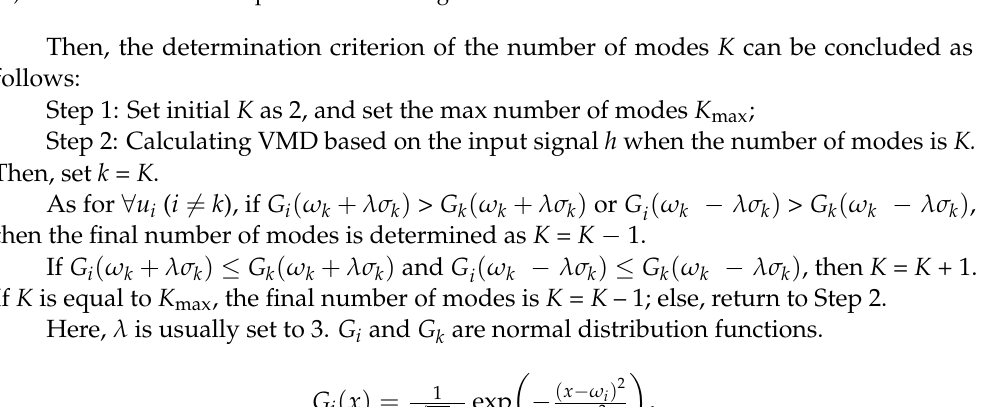
Figure 2. Illustration of the spectral overlap and the relaxation time map. ( a ) The spectral overlap. ( b ) The relaxation time map and its line